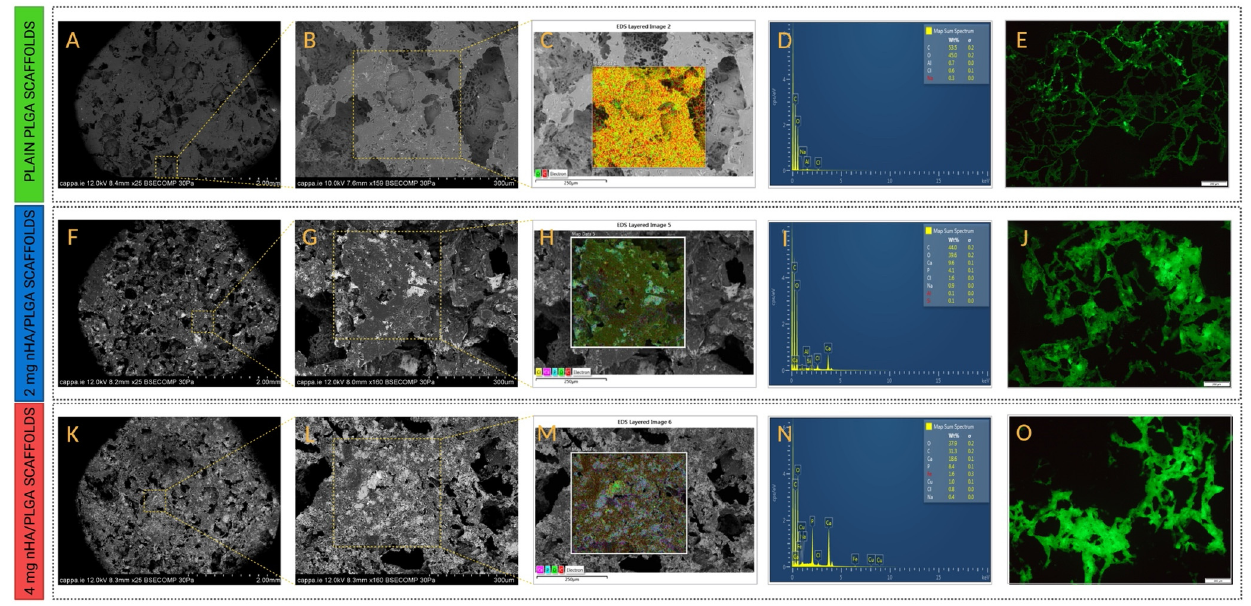
Figure 3. Representative energy dispersive SEM/X-Ray images of specific ROI in the different scaffolds (magnification ×160) and calcein fluorescence images of scaffolds (magnification ×10). ( A – E ) plain PLGA scaffolds; ( F – J ) 2 mg nHA/PLGA scaffolds; and ( K – O ) 4 mg nHA/PLGA scaffolds. Signal components indicative of PLGA include carbon (C), represented in red. nHA signatures include calcium (Ca) represented in purple and phosphorous (P) in light blue. Scale bar: 250 µ m. The Ca and P signals, major components of nHA, are absent in the map of ( D ) PLGA scaffolds and increasing between ( I ) 2 mg nHA/PLGA scaffolds and ( N ) 4 mg nHA/PLGA scaffolds.